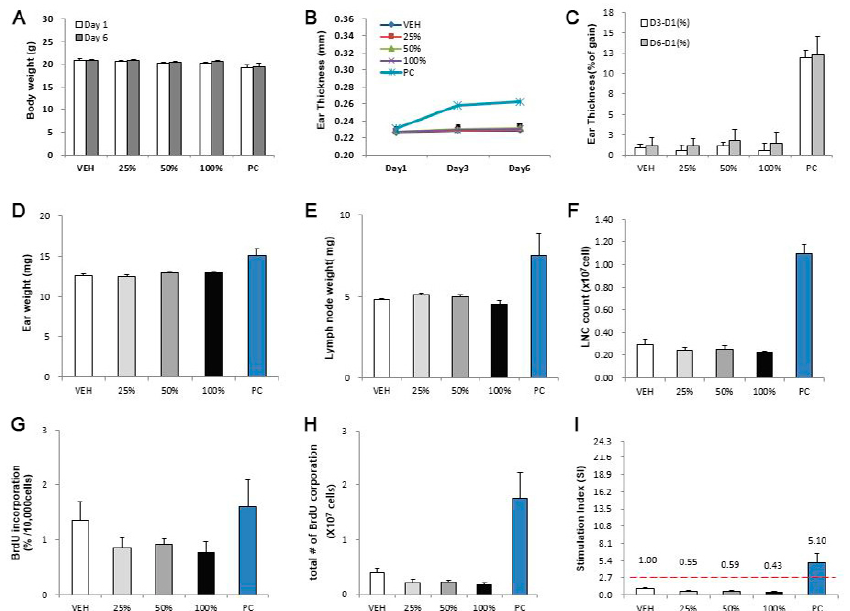
Figure 4. SWCNT skin sensitization test results in LLNA: BrdU-FCM assay. The evaluation parameters were as follows: ( A ) Body weight (g), ( B ) ear thickness (mm), ( C ) ear thickness (% of gain), ( D ) ear weight (mg), ( E ) lymph node weight (mg), ( F ) lymph node cell (LNC) count ( × 10 7 cells), ( G ) BrdU incorporation (% / 10,000 cells), ( H ) total number of BrdU corporation ( × 10 7 cells), ( I ) stimulation index (SI). Data are expressed as mean ± standard deviation values ( n = 4).